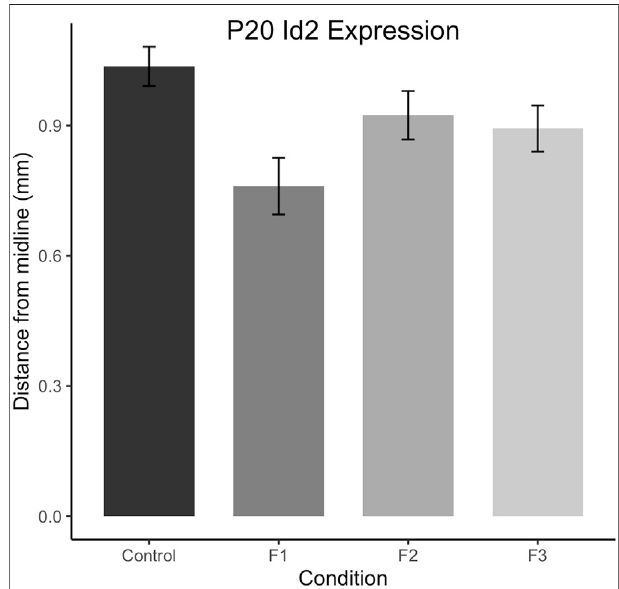
FIGURE 7 | Quanti fi cation of neoortical Id2 phenotype in F1 mice. Distance from the midline to the limit of the robust super fi cial band of Id2 expression was calculated for all cases at anatomically-matched sections in Control, F1, F2 and F3 mice at P20. F1 mice display signi fi cantly decreased distances from the midline compared to controls ( p <